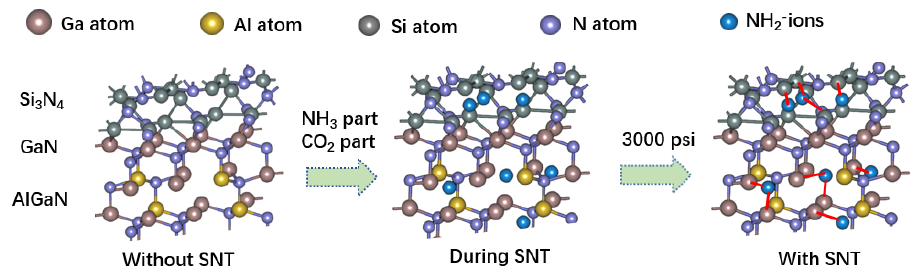
Figure 8. The supercritical nitridation technology model of the fabricated all-GaN integrated MIS-